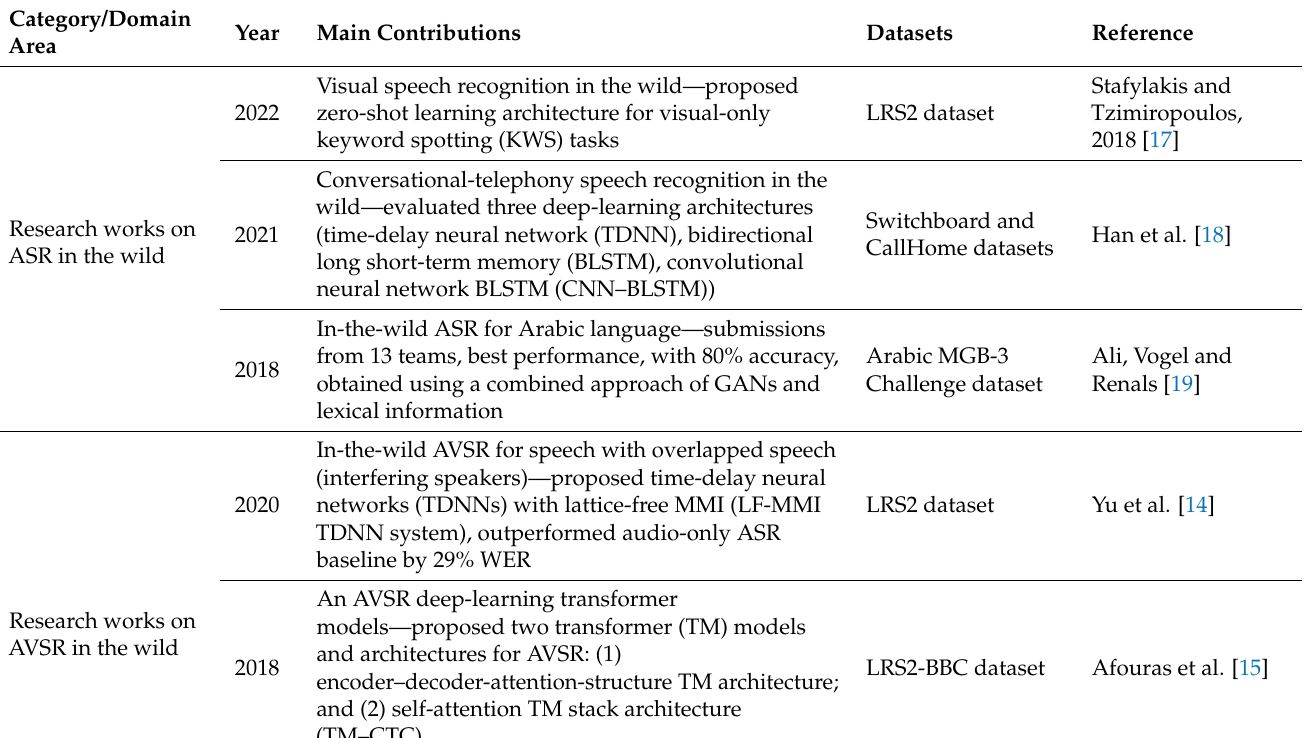
Table 1. Some representative works on multimodal-sensor architectures for ASR, AVSR and other applications in wild